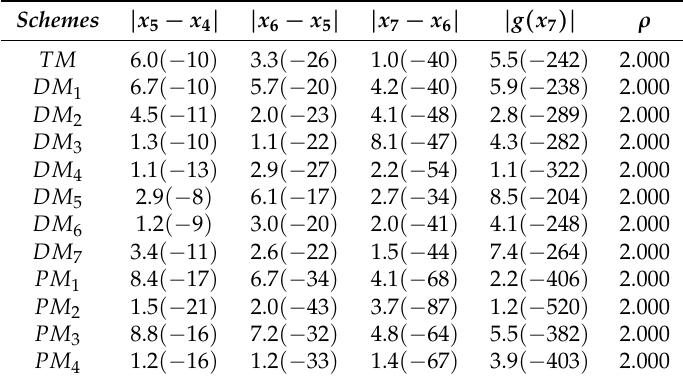
Table 3. Numerical results of Example